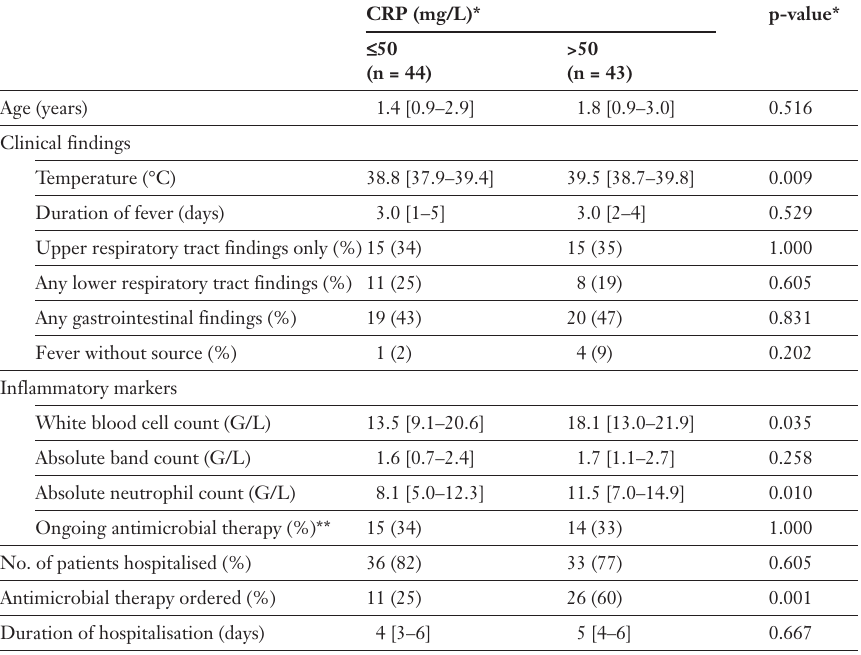
Findings in patients with adenovirus infection, grouped according to serum CRP concentration (cut-off value, 50